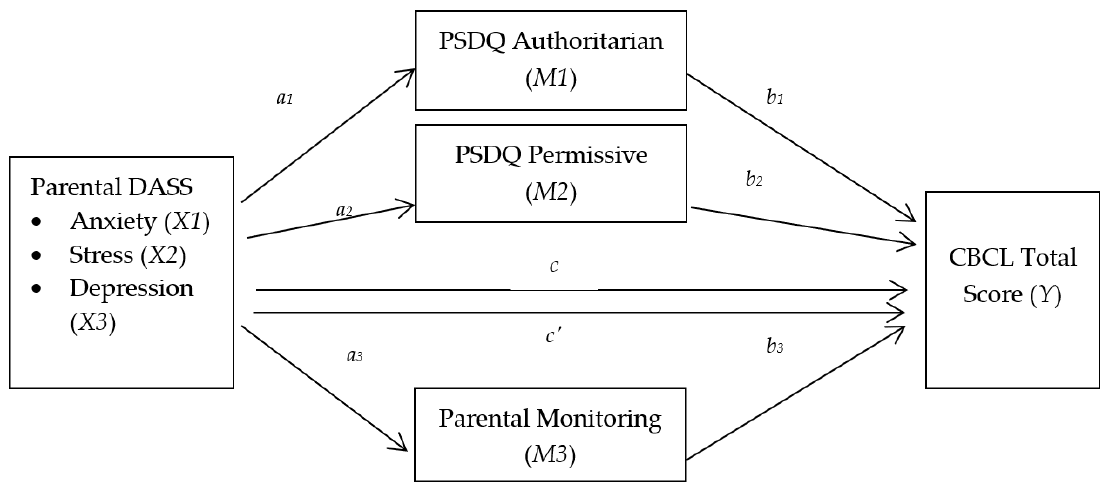
Figure 1. A conceptual diagram of the parallel multiple mediator model.